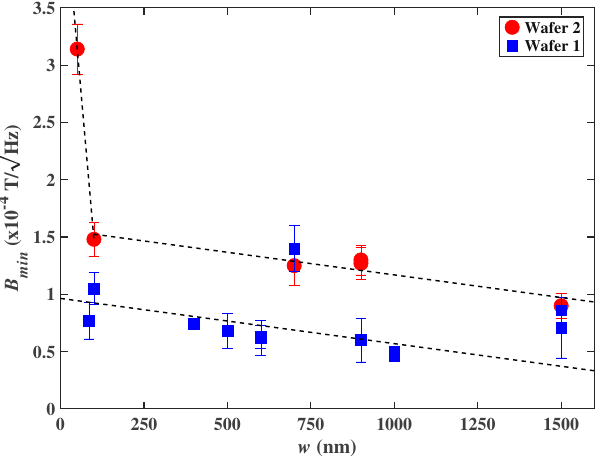
Figure 7. Estimated minimum detectable field as a function of wire width for a fixed drive current of 2 µ A at 531 Hz and similar values of R H in the range 140–180Ω/T. Solid circles and squares indicate samples fabricated from different CVD graphene wafers. Dashed lines are given as a guide to the eye.